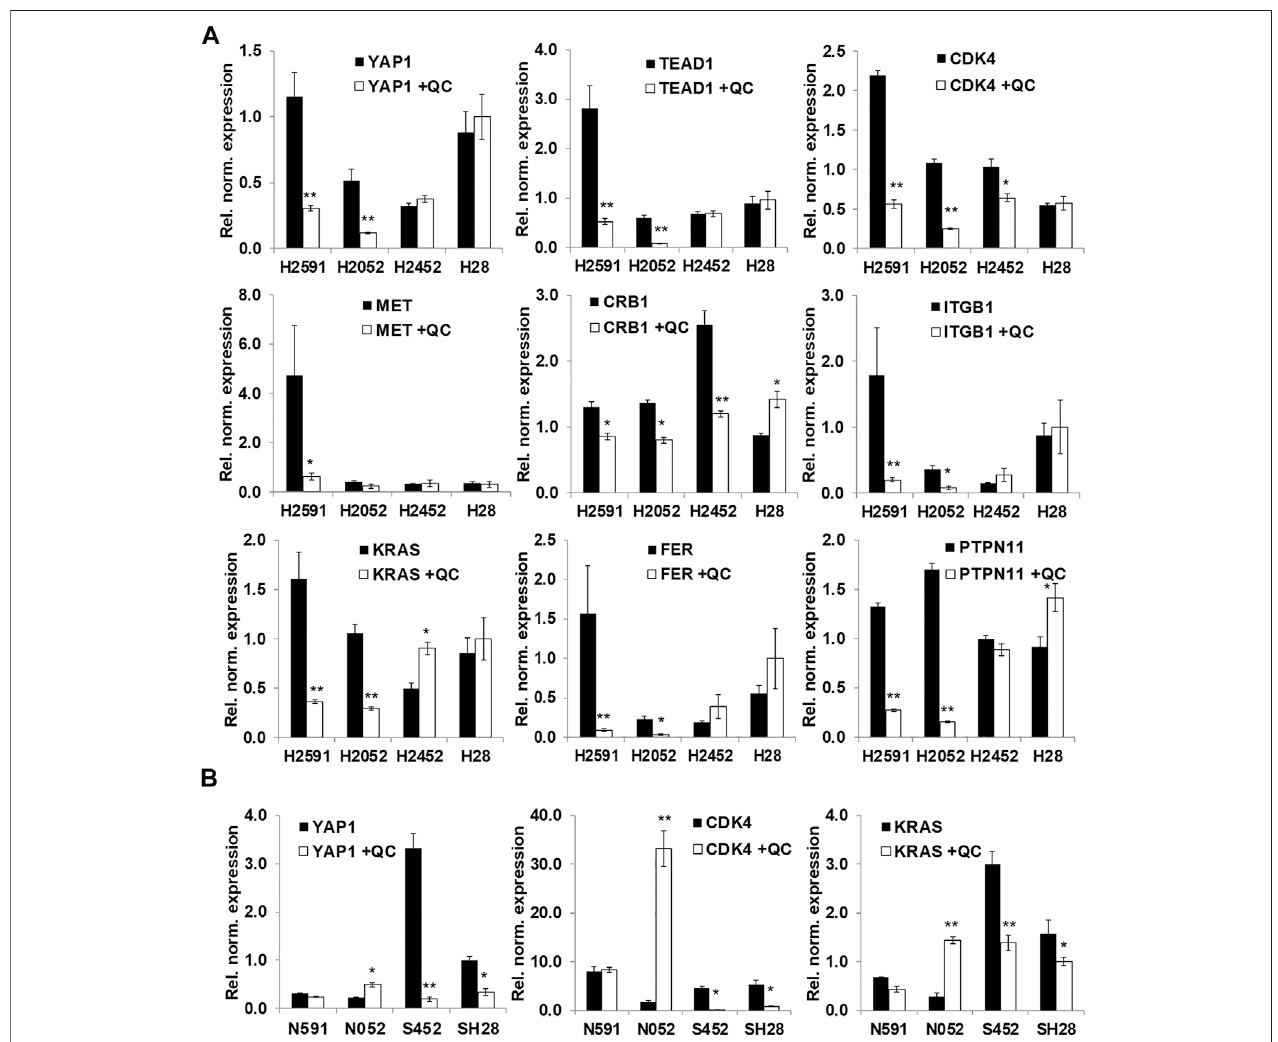
FIGURE 4 | Validation of RNA sequencing results with a focus on the hippo pathway. (A) qPCR validation of selected genes with quinacrine (QC, 5 µM for 6 h); (B) Quinacrine-inducedmRNAchangeswithNF2ectopicexpression(N591andN052representH2591andH2052withNF2expression,respectively)andsiRNAknockdownofNF2 (S452 and SH28 represent H2452 and H28 with NF2 shRNA, respectively). Values represent expression normalized to RPLP0. * p < 0.05, ** p < 0.005.